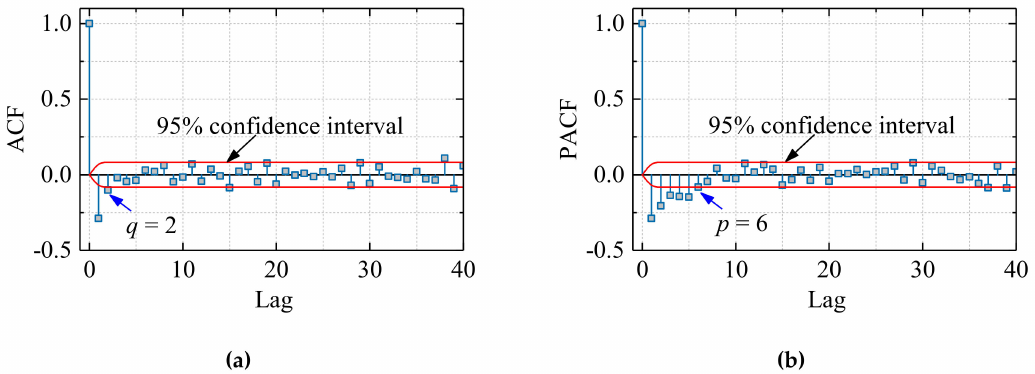
Figure 6. ACF and PACF of the differenced dataset. ( a ) ACF; ( b )